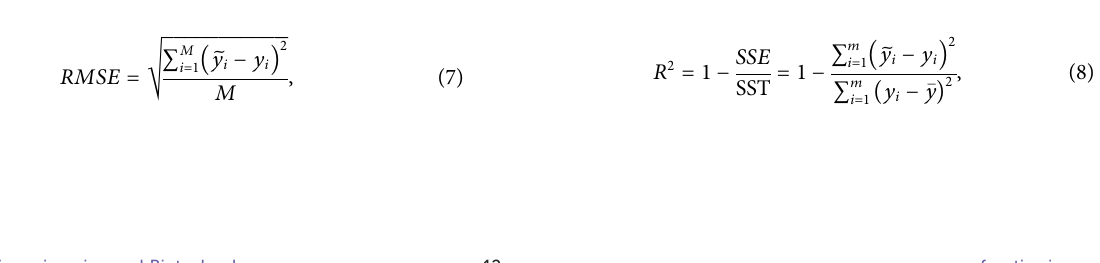
Frontiers in Bioengineering and